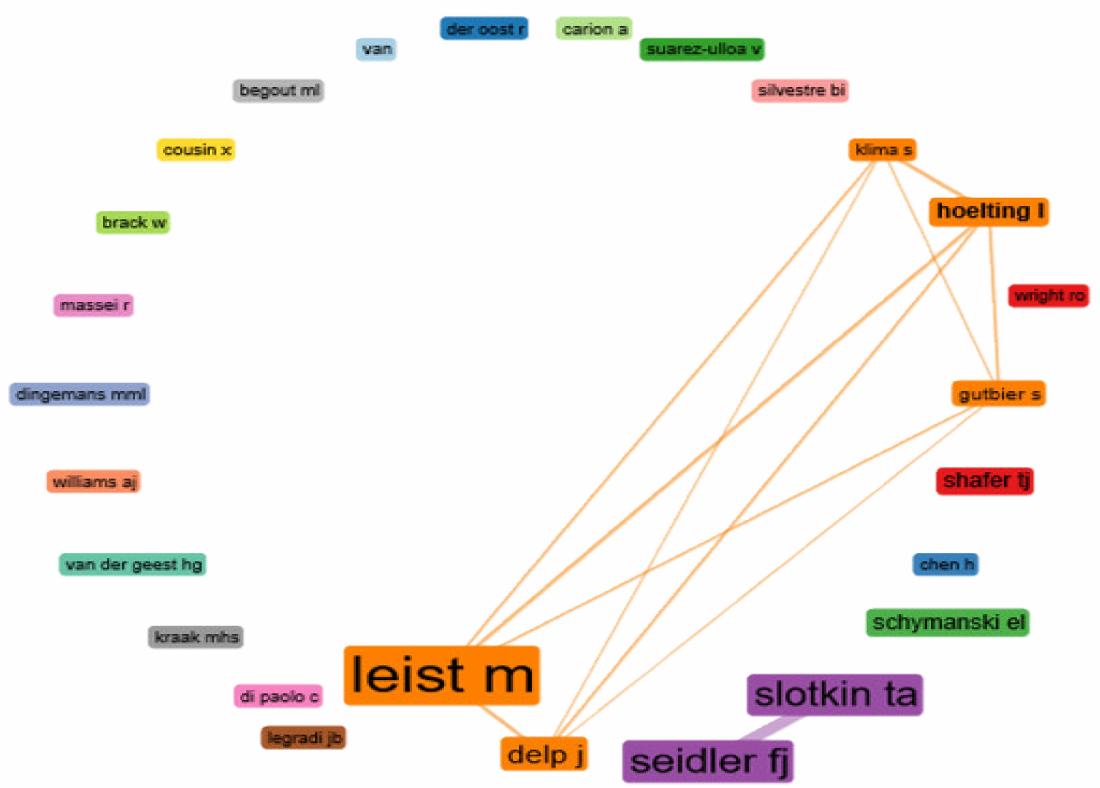
Figure 3. Authors’ collaboration among various institutions between 2011 and